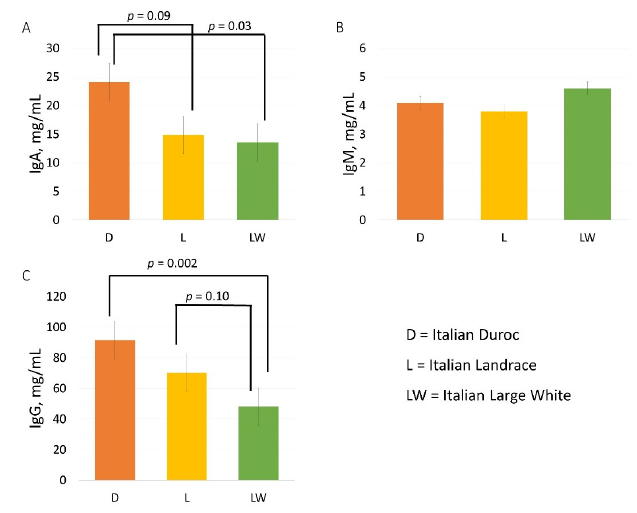
Figure 1. The effect of breed on the concentration of immunoglobulins in swine colostrum (least square means with SEM). ( A ) = Effect of breed on the concentration of IgA; ( B ) = Effect of breed on the concentration of IgM; ( C ) = Effect of breed on the concentration of IgM. Stepwise Regression and the subsequent ANOVA analysis revealed that breed, sow productive performance (N of piglets born live and BW of piglets at birth), and